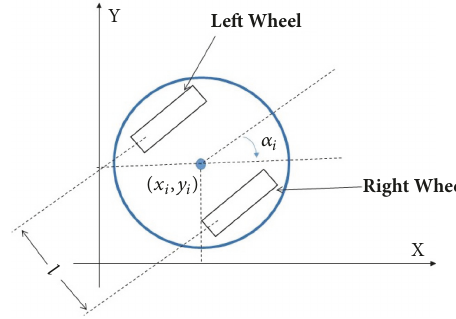
Figure 1: Differential-driven-wheeled mobile robot